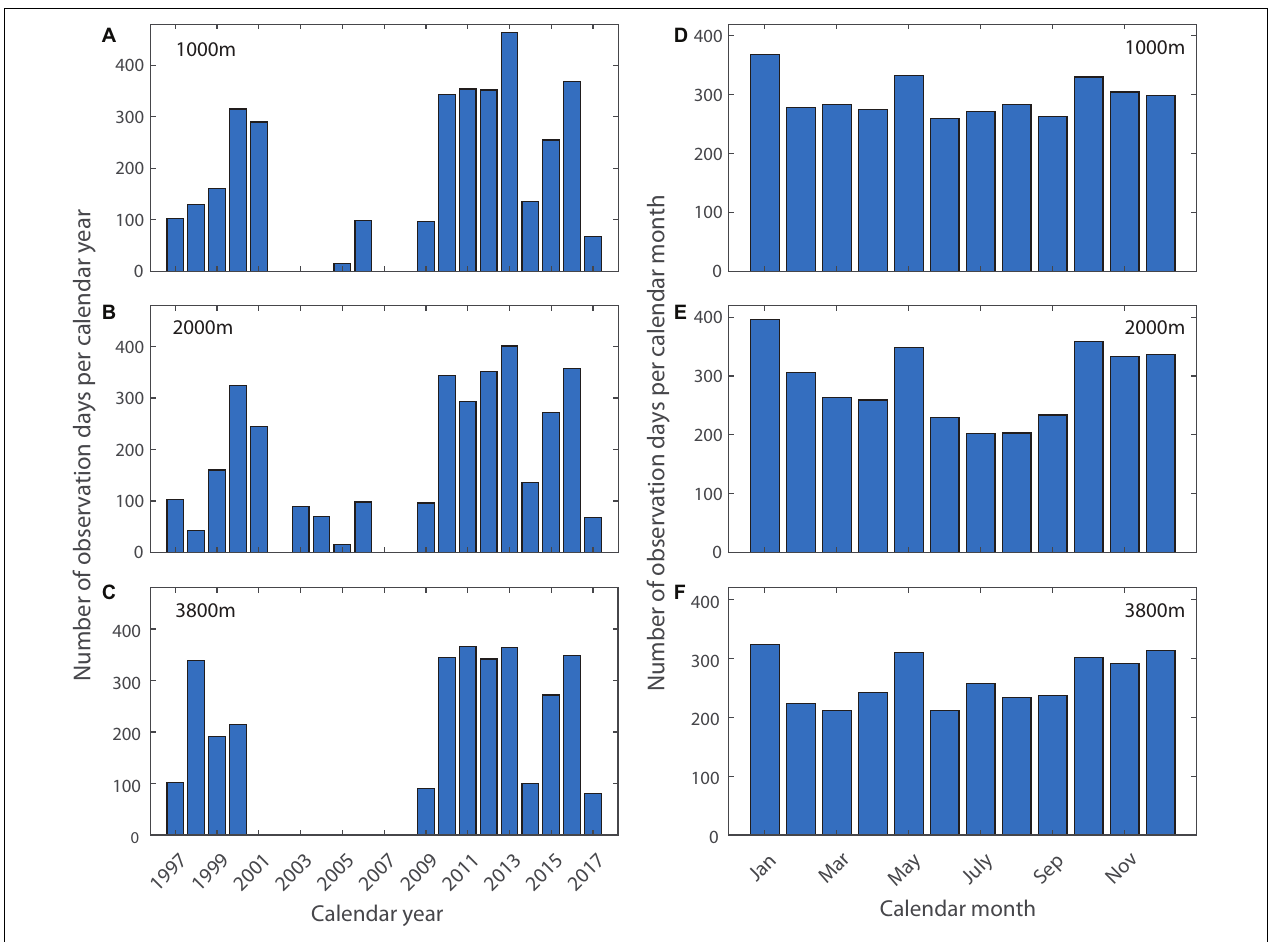
FIGURE 2 | Statistics of 47 ◦ S sediment trap data per calendar year [ (A) 1000 m, (B) 2000 m, (C) 3800 m] and month [ (D) 1000 m, (E) 2000 m, (F) 3800 m]. During the calendar year 2013, two moorings were in the water at the same time for a short period, leading to observation days that exceed